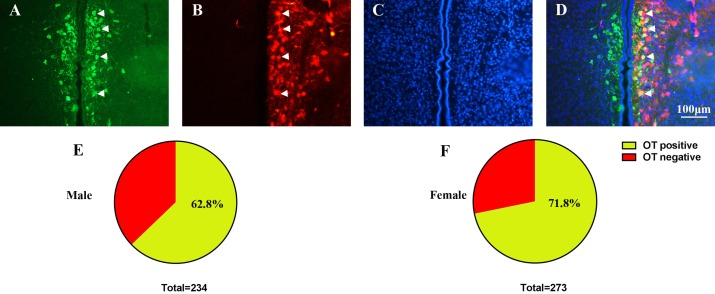
Representative immunostaining allowing the vizualization of (A) OT expression (green), (B) mCherry (red) and (C) DAPI (blue) in PVN neurons of PD voles.(D) Colocalization image including bands (A), (B) and (C). Arrowheads indicate the OT, mCherry and DAPI. Quantiﬁcation of OT–meCherry colocalization in (E) males (147/234 = 62.8%, from two voles) and (F) females (203/283 = 71.7%, from two voles).